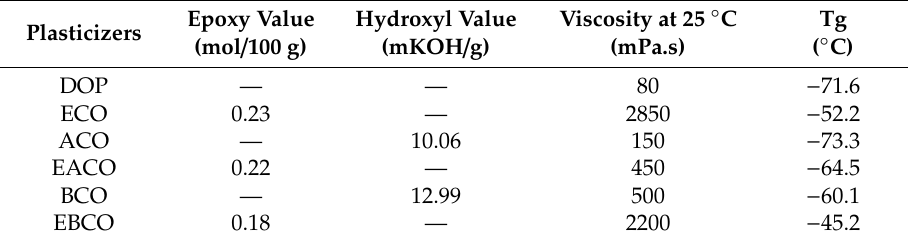
Table 1. Physical properties of